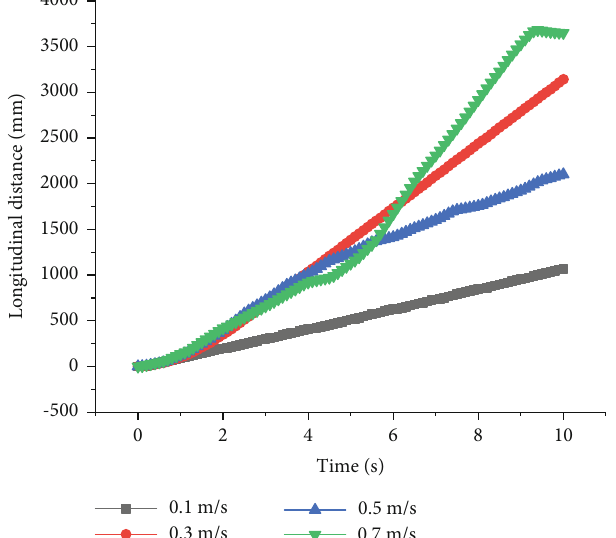
Figure 4: Longitudinal distances of quadruped robots with elbow joint for front legs and knee joint for back legs with di ff erent speed at a constant